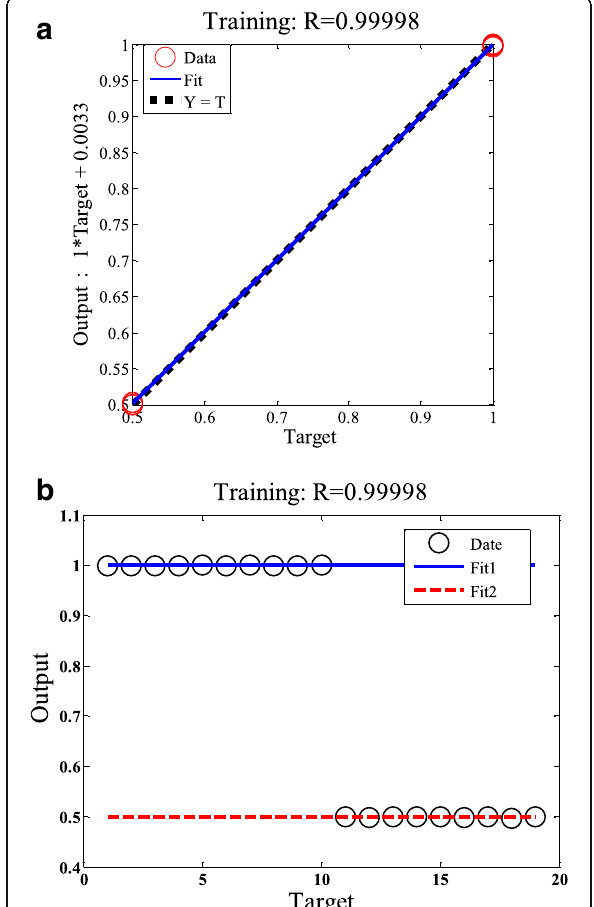
Fig. 3 The results of training. a Regression. b The data